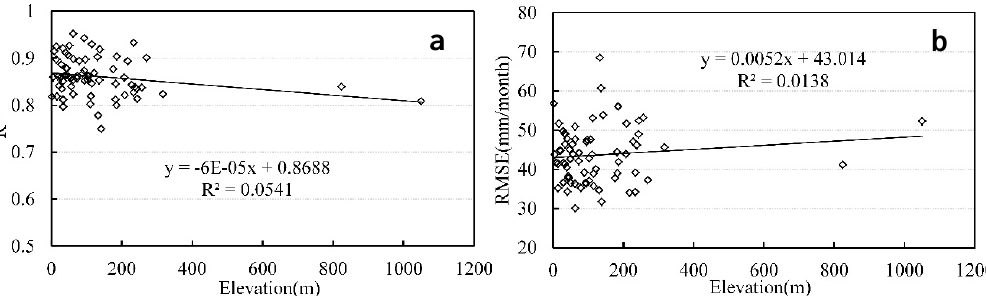
Figure 11. Spatial distribution of statistical indices at monthly scale, including R 2 , NRMSE and NMAE . Water 2016 , 8 , 281